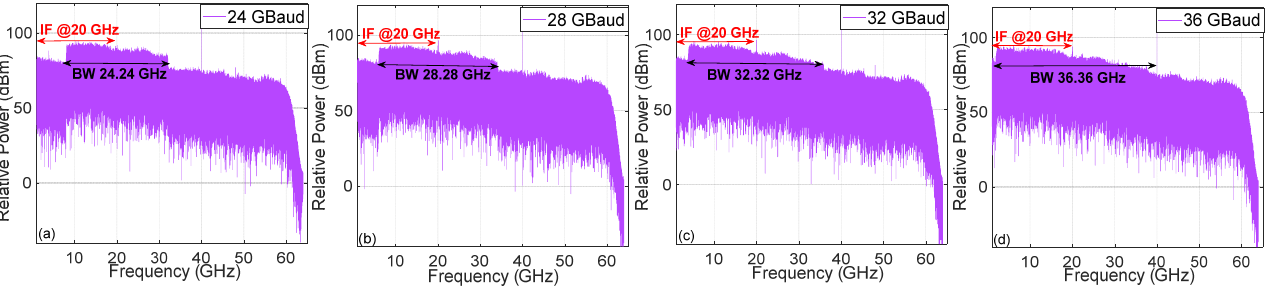
Figure 6. Electrical spectrum of the received QPSK IF signal: ( a ) 24 GBaud signal with 24.24 GHz BW; ( b ) 28 GBaud signal with 28.28 GHz BW; ( c ) 32 GBaud signal with 32.32 GHz BW; ( d ) 36 GBaud signal with 36.36 GHz BW.